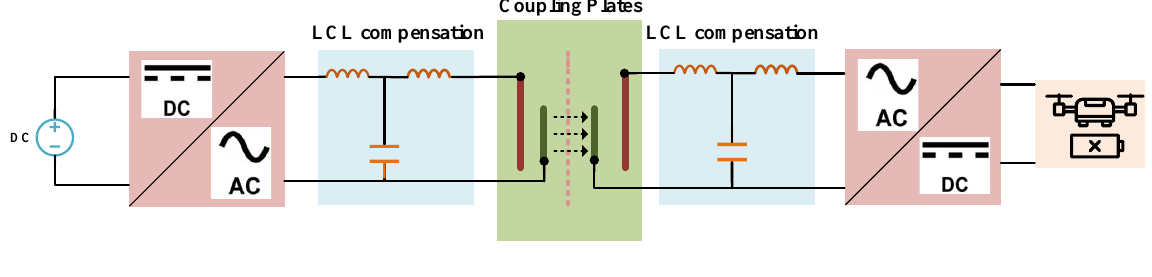
Figure 4. Double-sided LCL compensated circuit topology